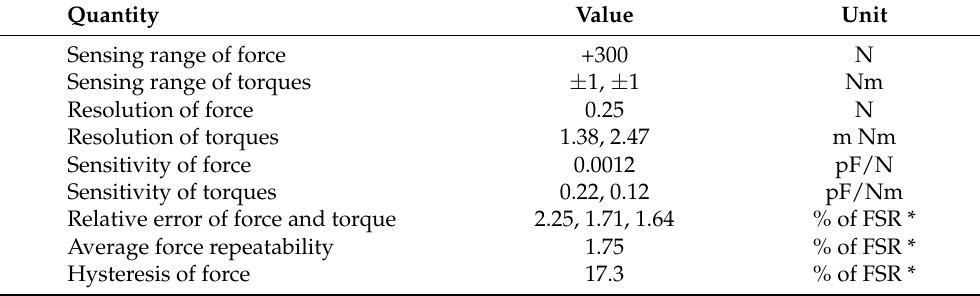
Table 2. Specifications of the